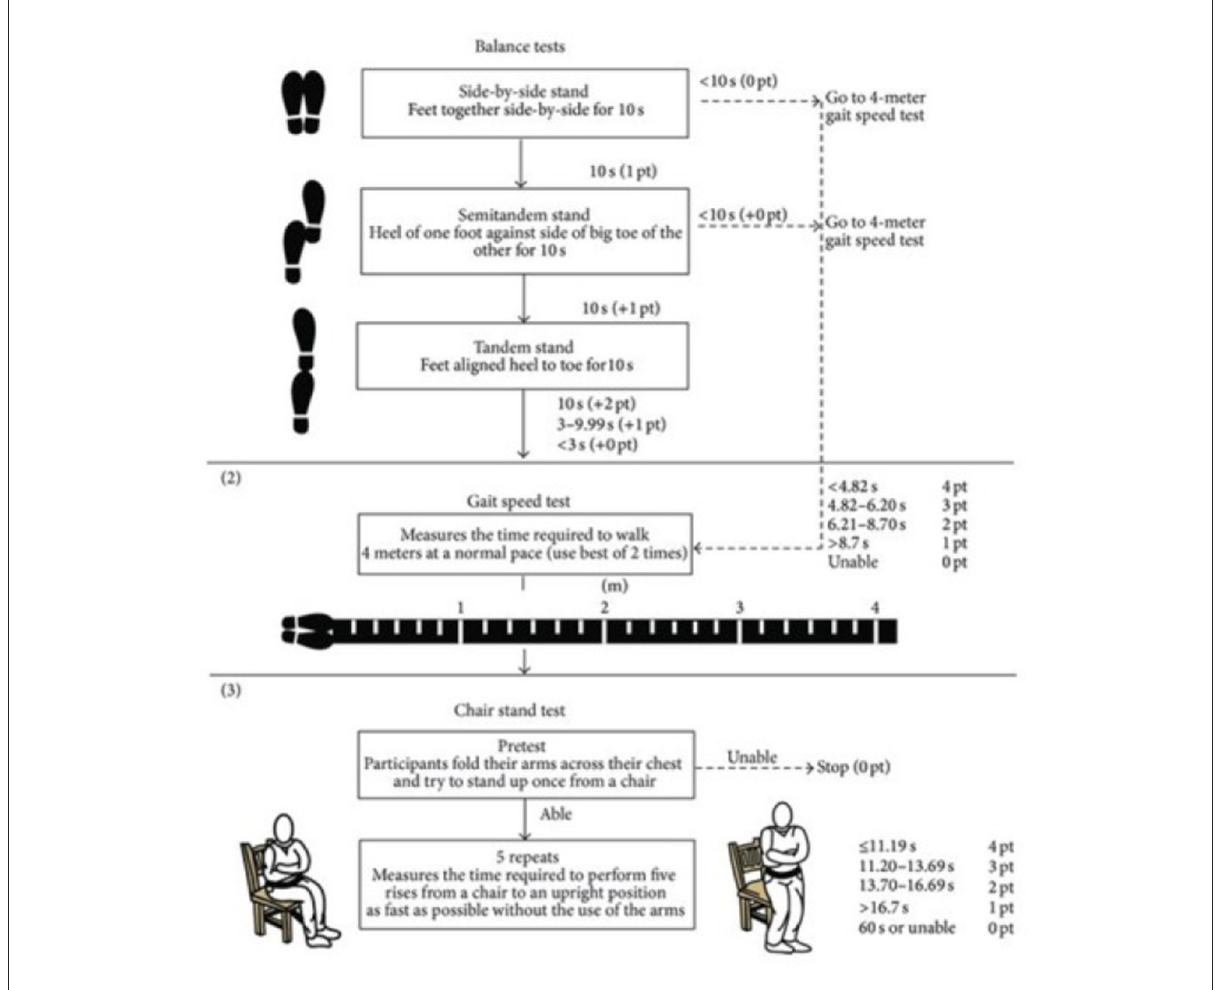
FIGURE4 SPPB test